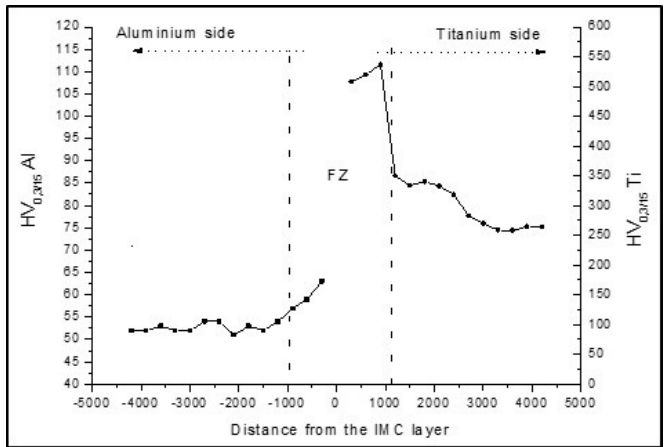
Figure 8. Microhardness profile at half thickness of the weld cross section.